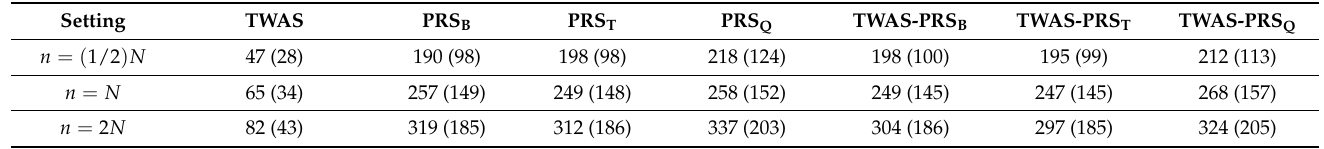
Table 2. The number of genes identified by seven methods under different settings. The numbers in the parentheses indicate the number of identified genes that are reported in TWAS hub (http: //twas-hub.org/; accessed on 2 January